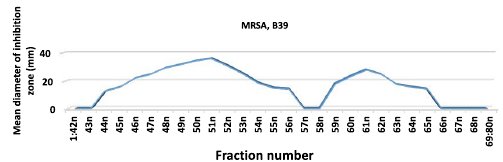
Fig. 3. Fractionation pattern of active antimicrobial substances from P. plebeium ( PP) extract and their effect against MRSA, B39